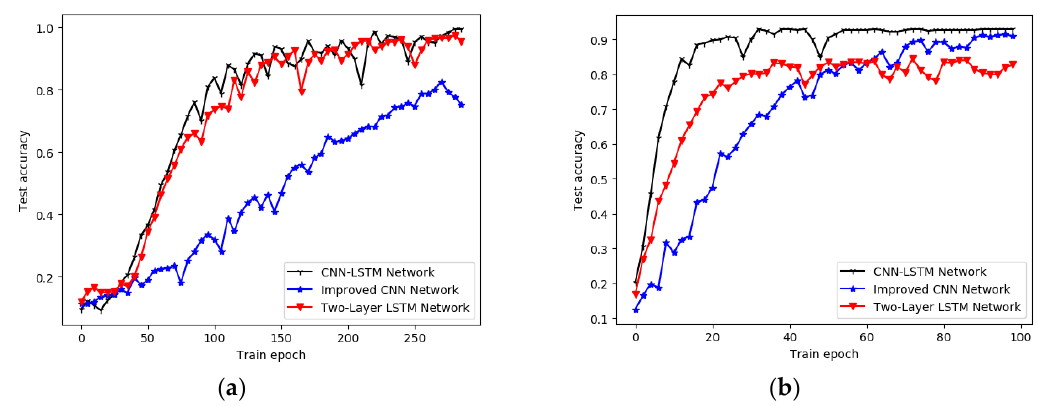
Figure 12. Test accuracy of different networks on ( a ) simulated datasets and ( b ) field datasets. Table 5. Confusion matrix obtained by CNN network on simulated datasets. Diameter